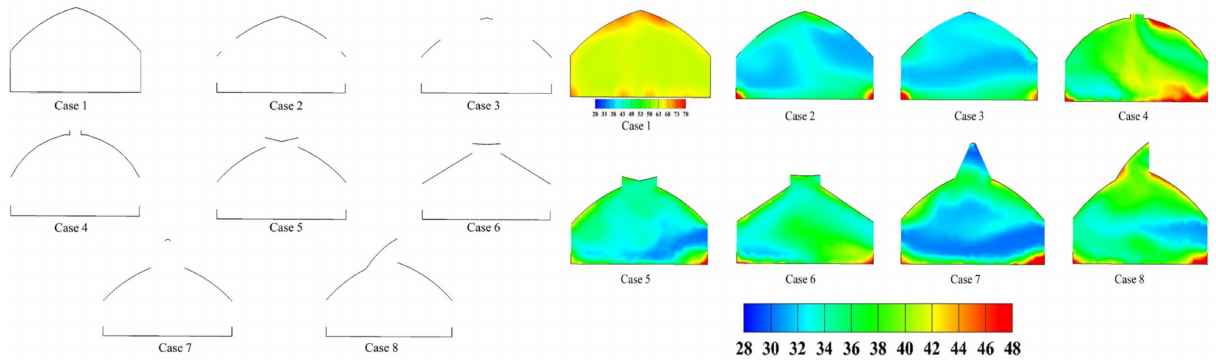
Figure A1. Configuration and contours of inside air temperature of greenhouses as presented by Rasheed et al.